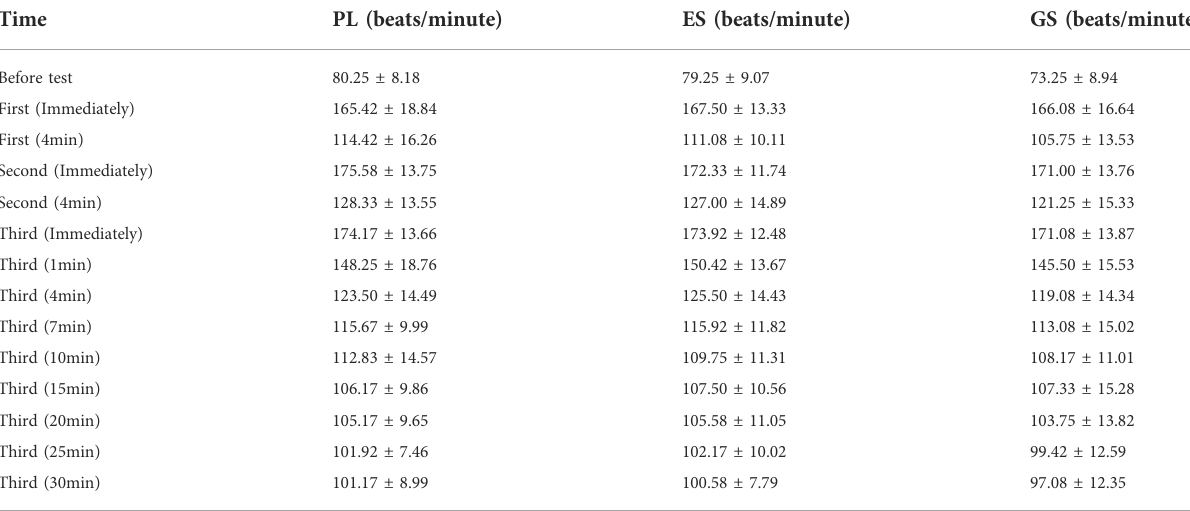
TABLE 2 HR responses during three experimental conditions.